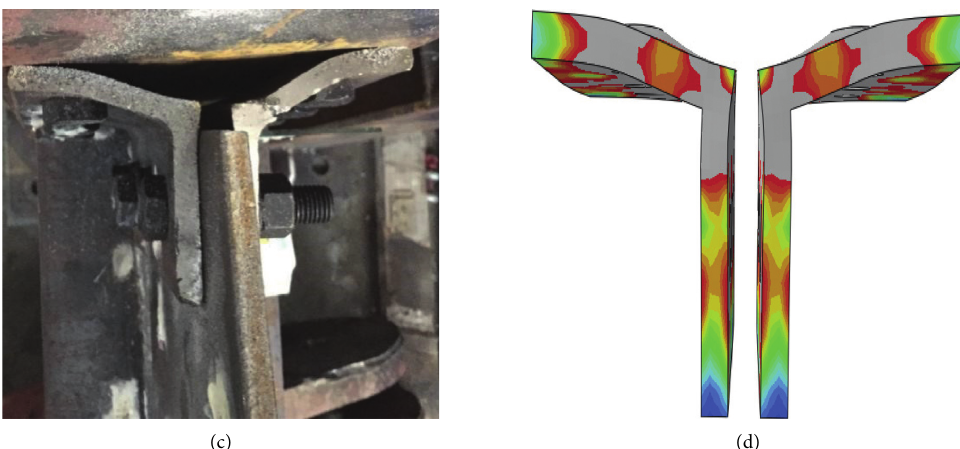
Figure 11: Comparison of ultimate failure states of SJA-2. (a) Overall test deformation. (b) Finite element deformation. (c) Gusset angle steel test deformation. (d) Gusset angle steel finite element